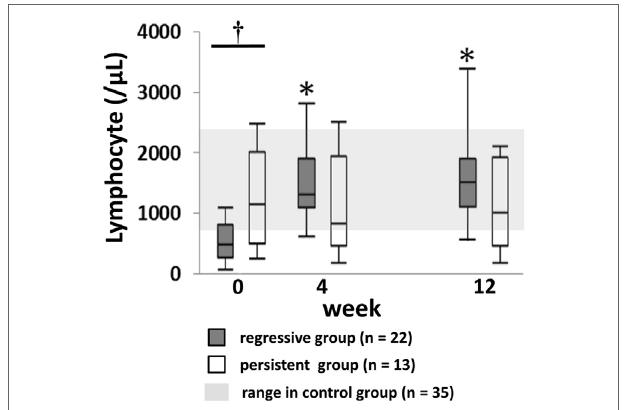
Figure 2 | Changes of lymphocyte numbers after MTX cessation in lymphoproliferative disorder (LPD) patients. Change in lymphocyte counts in regressive and persistent LPD compared with the range in the control group. Kruskal–Wallis test was used for comparing the three groups. † Regressive vs. control, P < 0.05; regressive vs. persistent, P < 0.05. * P < 0.05 for comparison with the value at week 0 in each group. MTX, methotrexate.